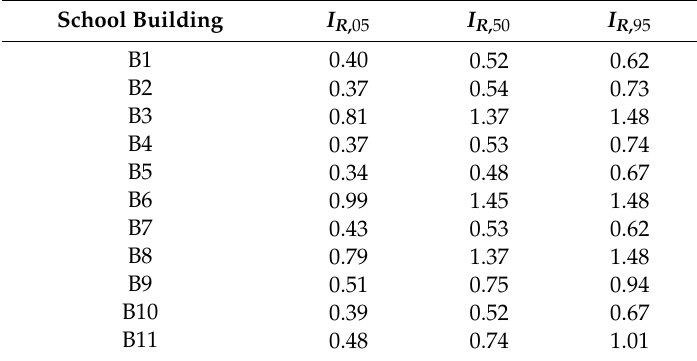
Table 2. Statistics of seismic risk index in the 11 case